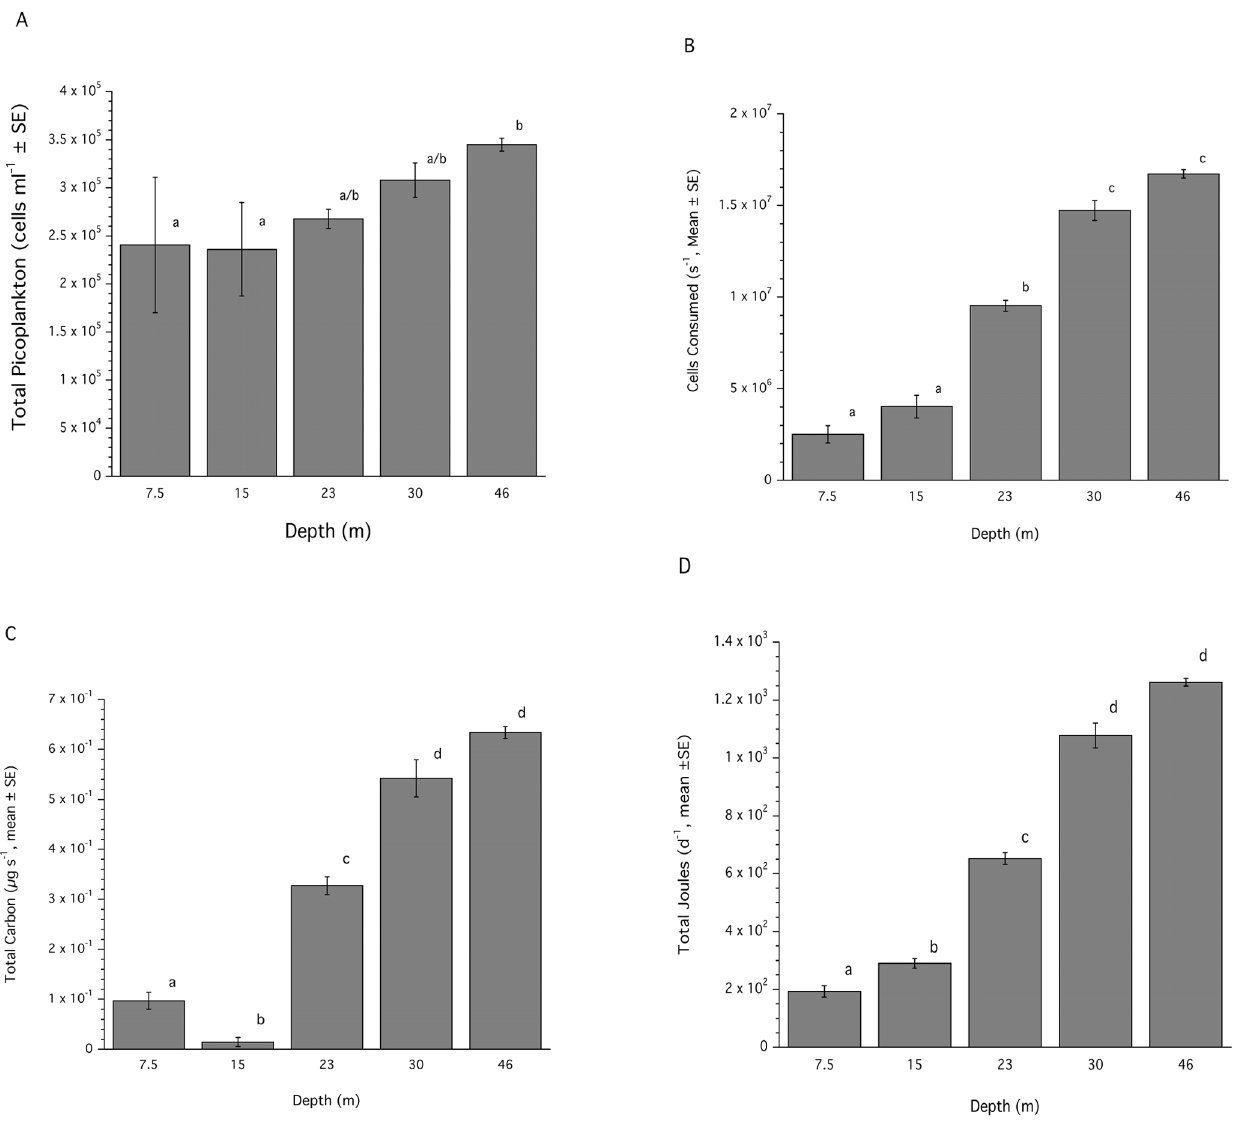
Figure 3. Picoplankton availability and feeding for Callyspongiavaginalis on Carrie Bow Cay, Belize. Depth-dependent concentrations of total picoplankton (A). Instantaneous total cells consumed per individual at each depth (B). Instantaneous intake of total particulate carbon per individual (C). Daily intake of total energy (J) per individual (D). Common superscripts indicate groups not significantly different from each other.